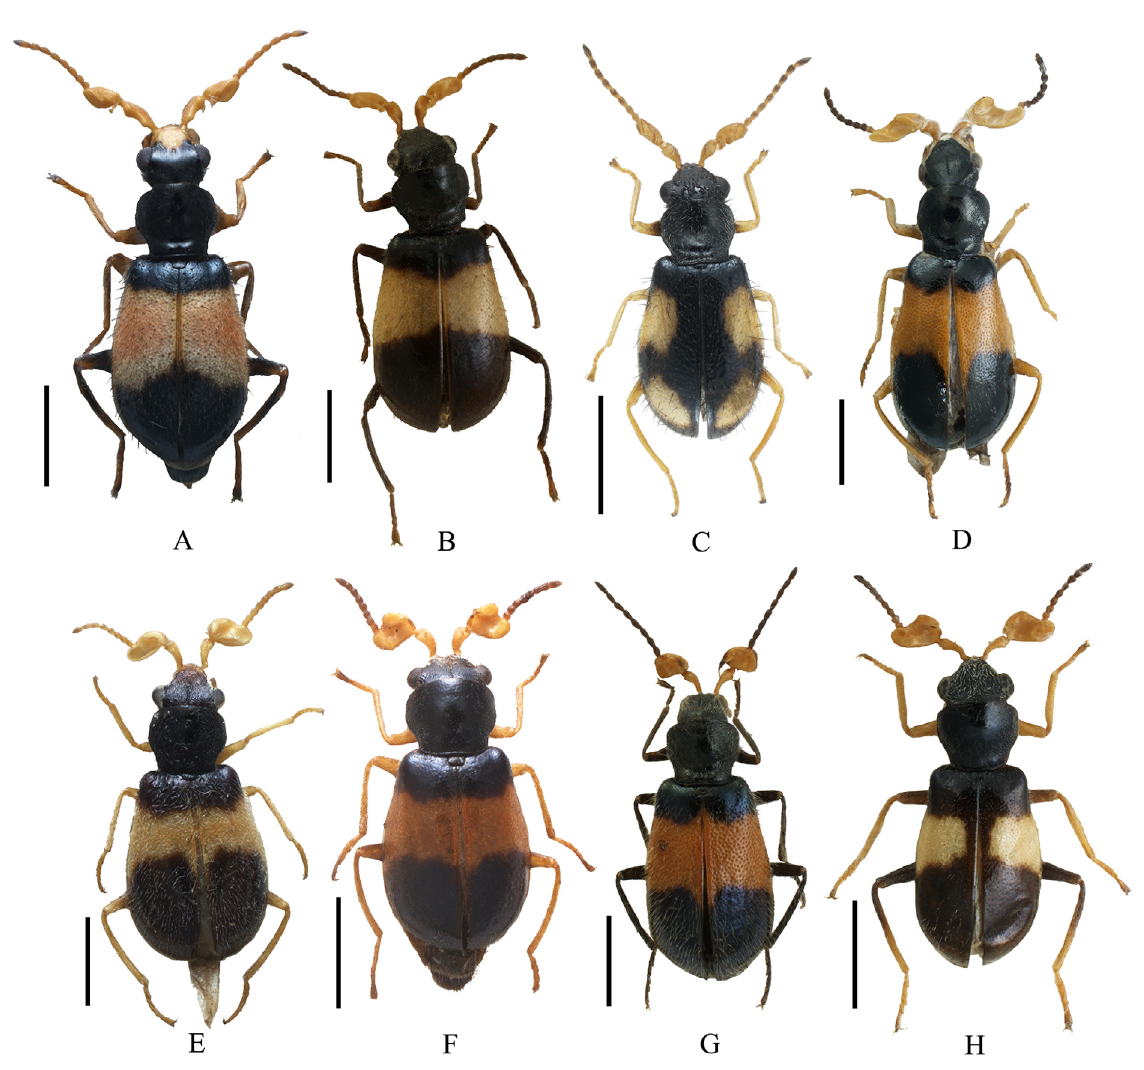
Fig. 1. Dorsal habitus Intybia spp., ♂. A . Intybia histrio (Kiesenwetter, 1874). B . I. tsushimensis (Satô & Ohbayashi, 1968). C . I. donan sp. nov., holotype. D . I. pelegrini pelegrini (Pic, 1910). E . I. niponica (Lewis, 1895). F . I. takaraensis (Nakane, 1955). G . I. kishiii (Nakane, 1955). H . I. kawasakii (Nakane, 1956), holotype. Scales = 1.0